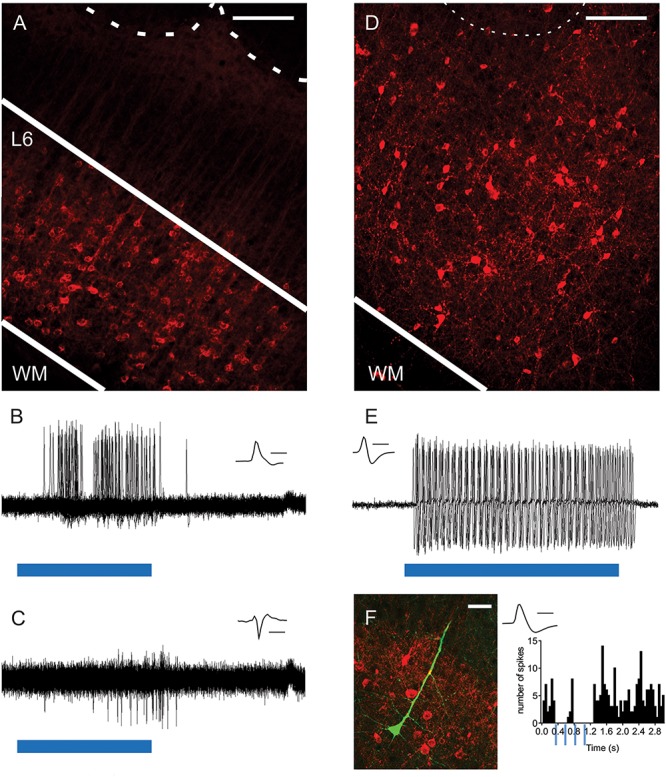
Optogenetic activation of L6-Ntsr1 and Gad2 cells expressing channelrhodopsin. (A) ChR2-mCherry expression in L6-Ntsr1 cells in the primary somatosensory barrel cortex. Fluorescent (red) somata in L6 and dendritic tufts and terminals in L5. The dotted lines represent the lower border of layer 4 barrels. (B)
In vivo juxtacellular recording of a L6-Ntsr1 cell expressing channelrhodopsin that responds with spikes to the 50ms light stimulation (blue bar; 0.6 mW). Recordings show the overlay of 50 sweeps. (C)
In vivo juxtacellular recording (overlay of 50 sweeps) of a putative fast-spiking (FS) L6 interneuron (depth: 872 μm). In this example the interneuron was driven via a relatively weak photoactivation of L6-Ntsr1 cells (0.6 mW, blue bar is 50 ms) (Increasing light intensity decreased spike latency, see Supplementary Figure S1). (D) Gad2-interneurons expressing ChR2-mCherry (red) were found in all layers in barrel cortex (see also Supplementary Figure S3). (E)
In vivo juxtacellular recording from a L2/3 Gad2-cre expressing interneuron labeled with ChR2-mCherry. The interneuron responded with spikes to light stimulation (0.6 mW; blue bar is 80 ms). Recordings show the overlay of 5 sweeps. (F) (Left) Image of a labeled pyramidal neuron (green) and ChR2-mCherry expressing Gad2-cre cells (Right) PSTH showing that spiking in this pyramidal cell decreased with light stimulation of Gad2 cells (4 light pulses each 80 ms at 4Hz). Scale bars: (A,D) = 150 μm; (F) = 30 μm. Inset (B,C,E,F) Spike shape of the recorded neuron, scale bar = 1 ms. WM, white matter.